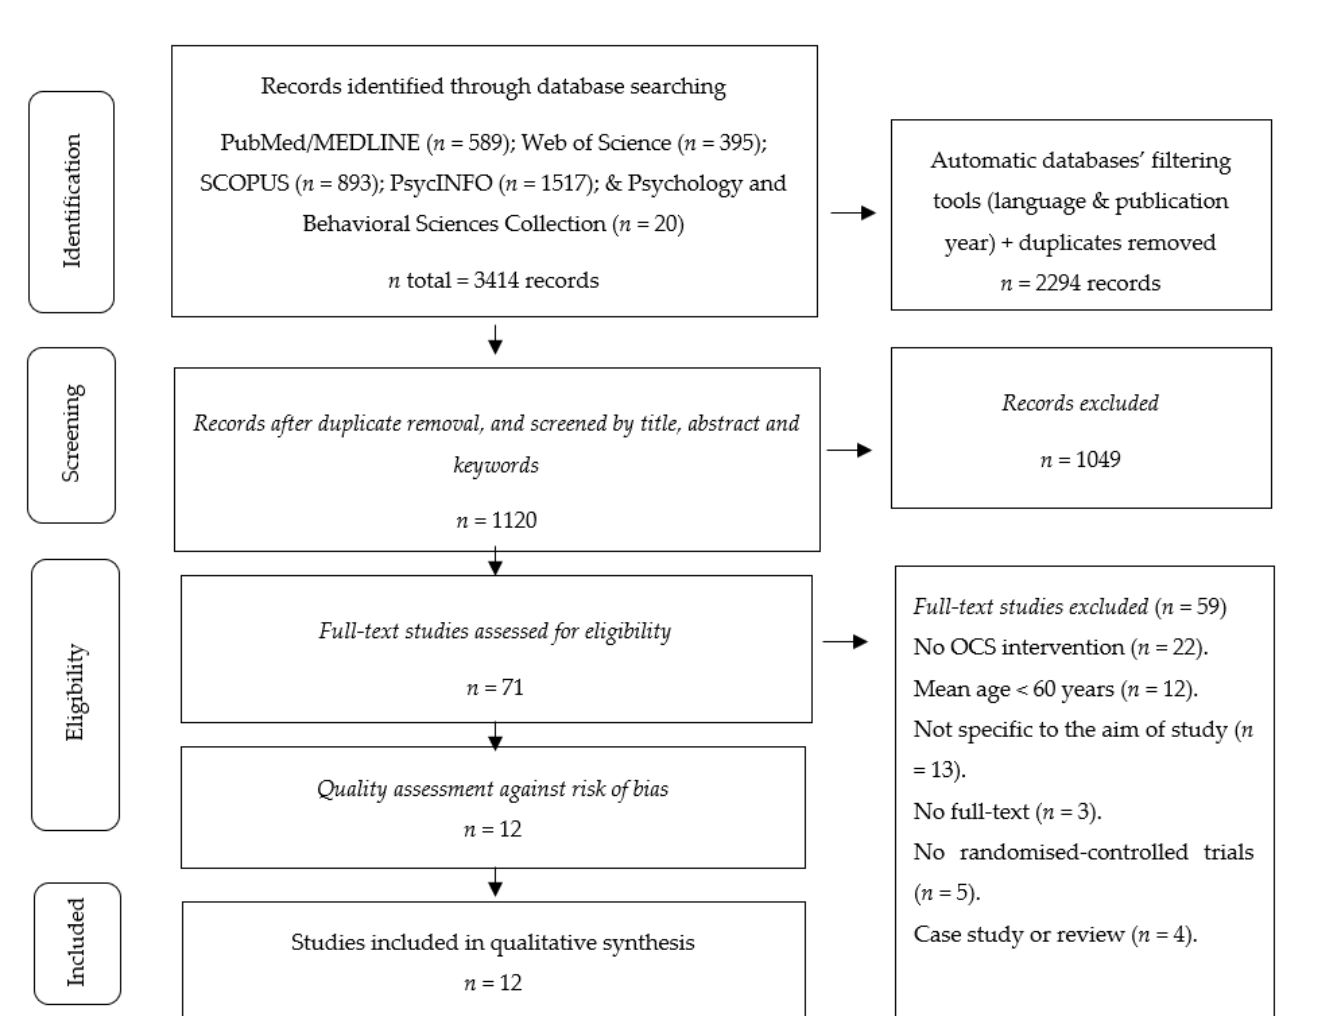
Figure 1. Flowchart of the review process#. #Based on the PRISMA-P recommendations [25].